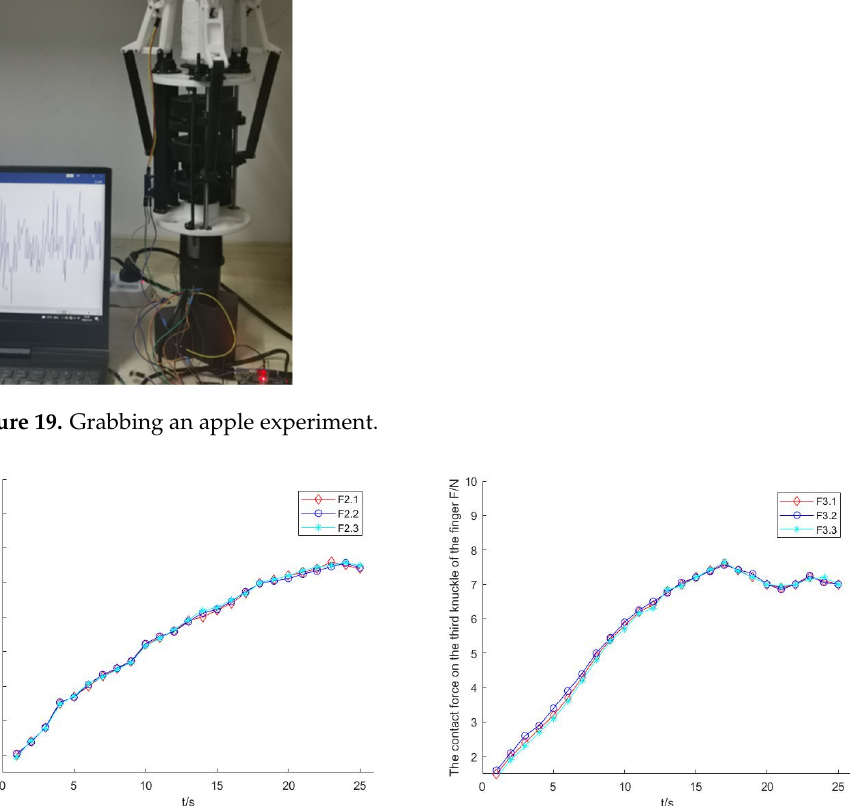
18 of 20 Figure 17. Grabbing a cylinder experiment.